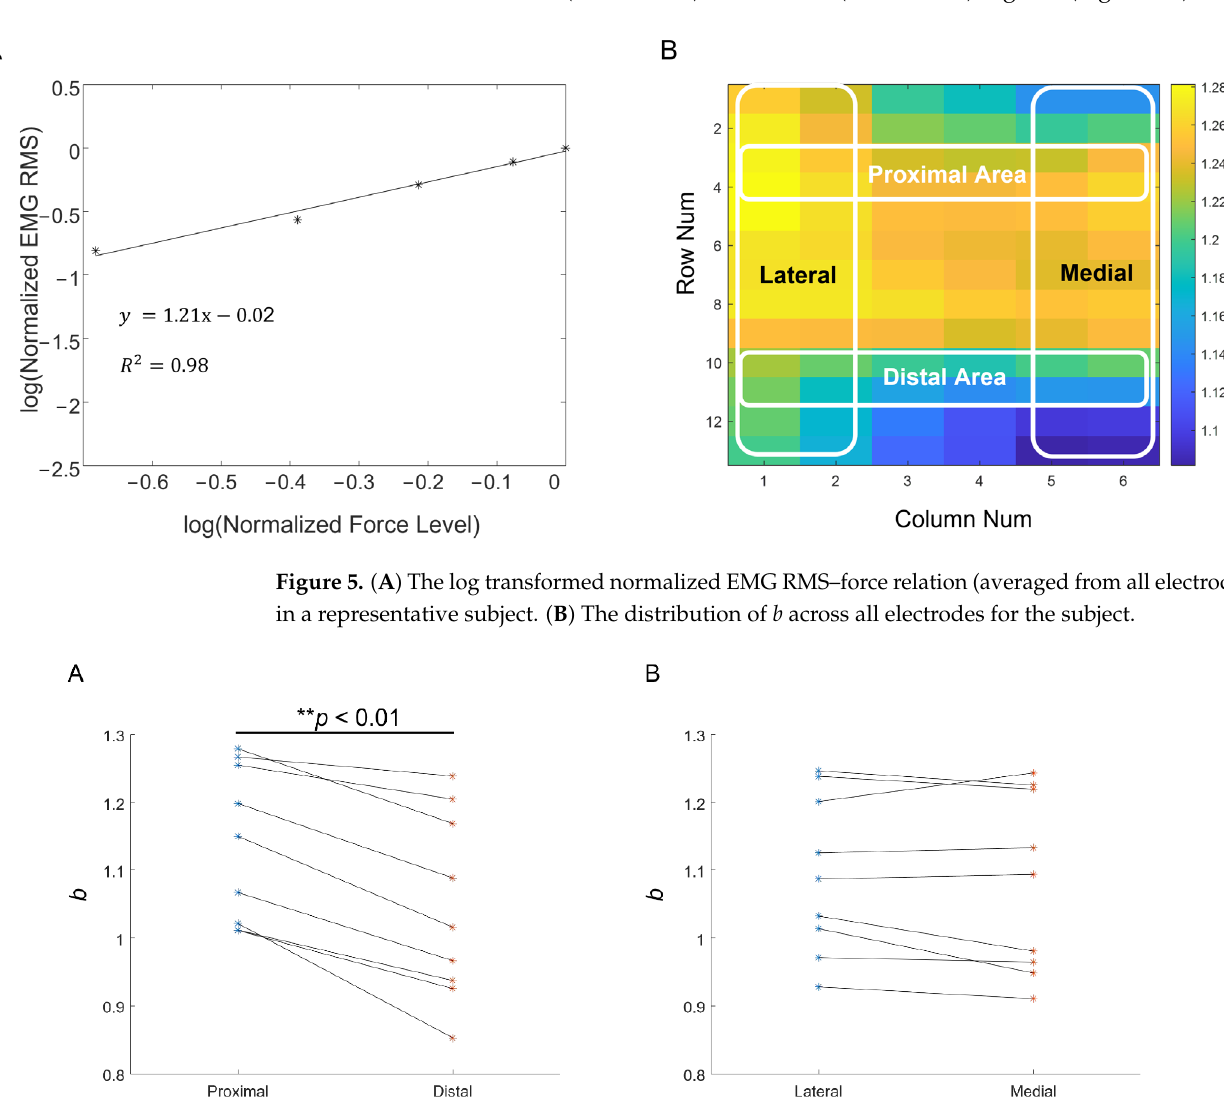
7 of 12 Figure 4. ( A ) Representative examples of log transformed EMG RMS–force relation when large mo- tor units were assumed to preferentially located in the superficial or deep regions of the muscle or unrelated to muscle depth (random). ( B ) The results for b of all the repetitions in each simulated condition. 3.2. Experimental Recording of the EMG–Force Relation